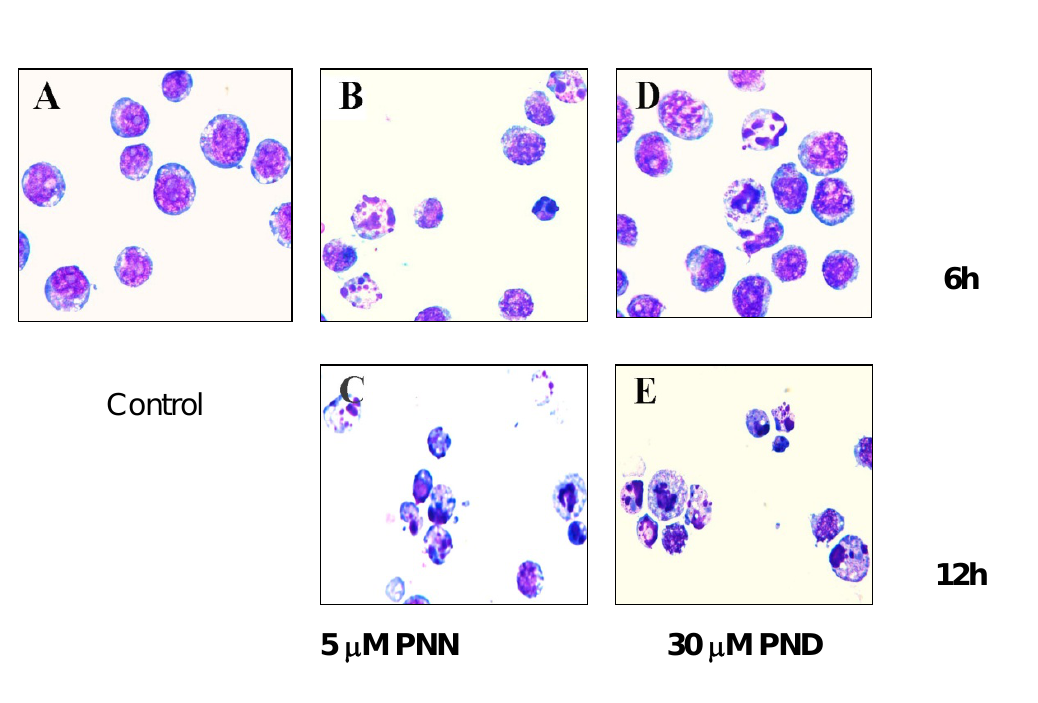
Figure 3. Representative fields showing apoptotic cells. HL60 cells were treated without ( A ) and with 5 μ M PNN for 6 h ( B ) and 12 h ( C ), with 30 μ M PND for 6 h ( D ) and 12 h ( E ). Cells were centrifuged onto slides by cytospin (Shandon, Runcorn, 500